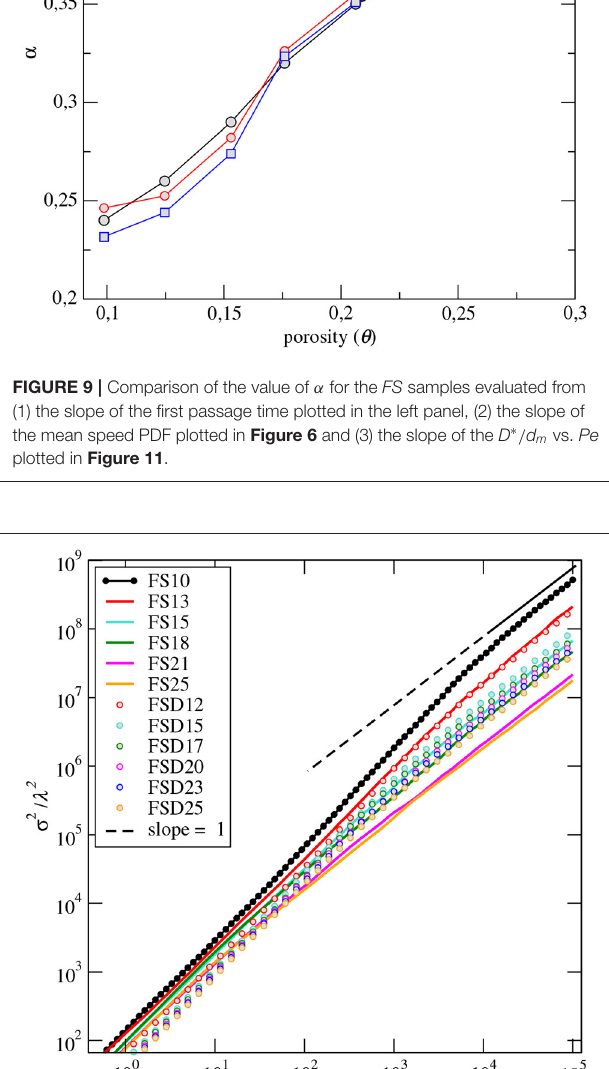
distribution is mainly determined by the distribution of fractions of fluid flowing at each of the network node and not by the overall tube size distribution. Our results lead us to a similar conclusion for the complex 3-dimensional porous media studied here. The evolution of the mean flow speed with porosity for the FS set